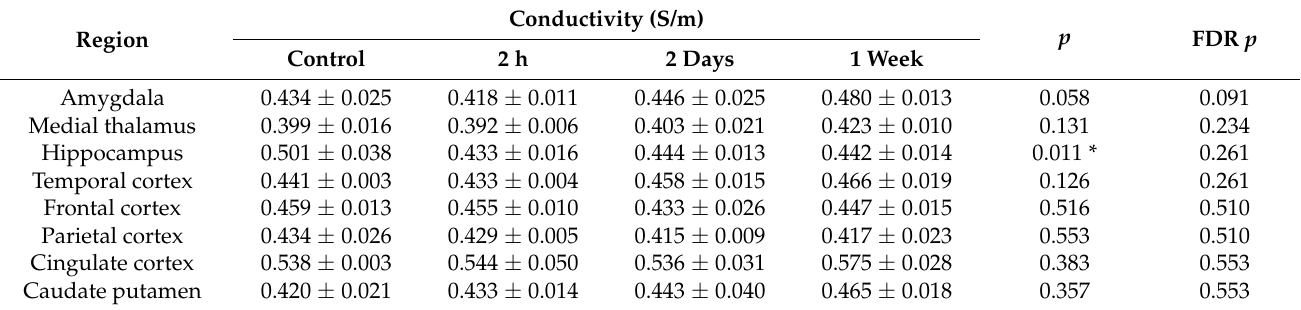
Table 1. High-frequency conductivity in the brain regions of NMDA-treated rats.